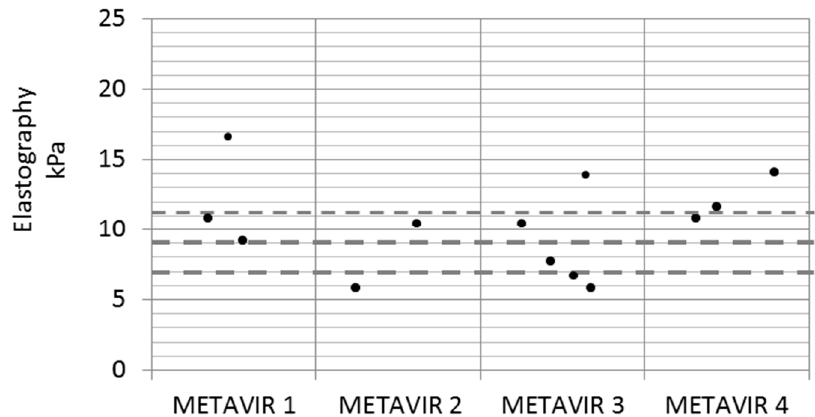
Figure 2. Relationship between Fibroscan ® and liver biopsy. We did not find good concordance in the classification of fibrosis between elastography and liver biopsy. Dashed lines indicate elastography cut-offs: 7, 9, and 11 kPa. Number of patients: Metavir 1, n = 3; Metavir 2, n = 2; Metavir 3, n = 4; Metavir 4, n = 3.